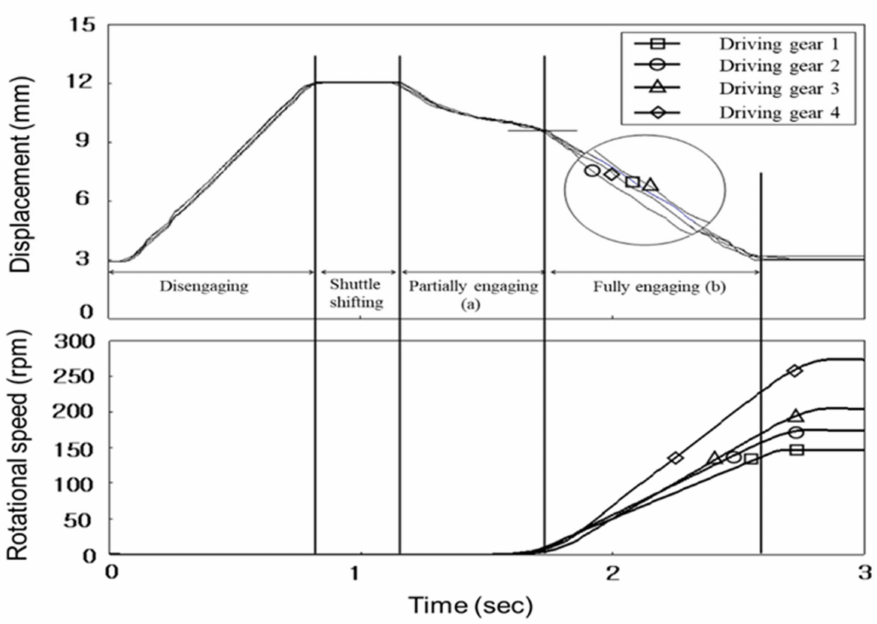
Figure 12. Position control performance of the clutch actuator according to each driving shift gear under range shift: 3rd. Table 4. Evaluation of shifting performance for clutch actuator according to each gear stage.